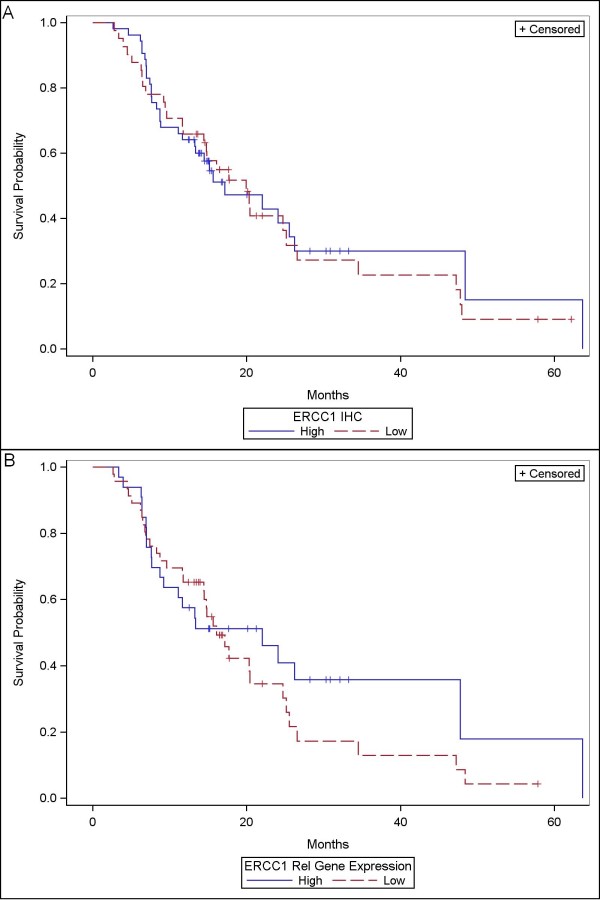
Kaplan Meier curve for overall survival according ERCC1 expression by: A) - IHC (P = 0.83) and B) - PCR (P = 0.39).